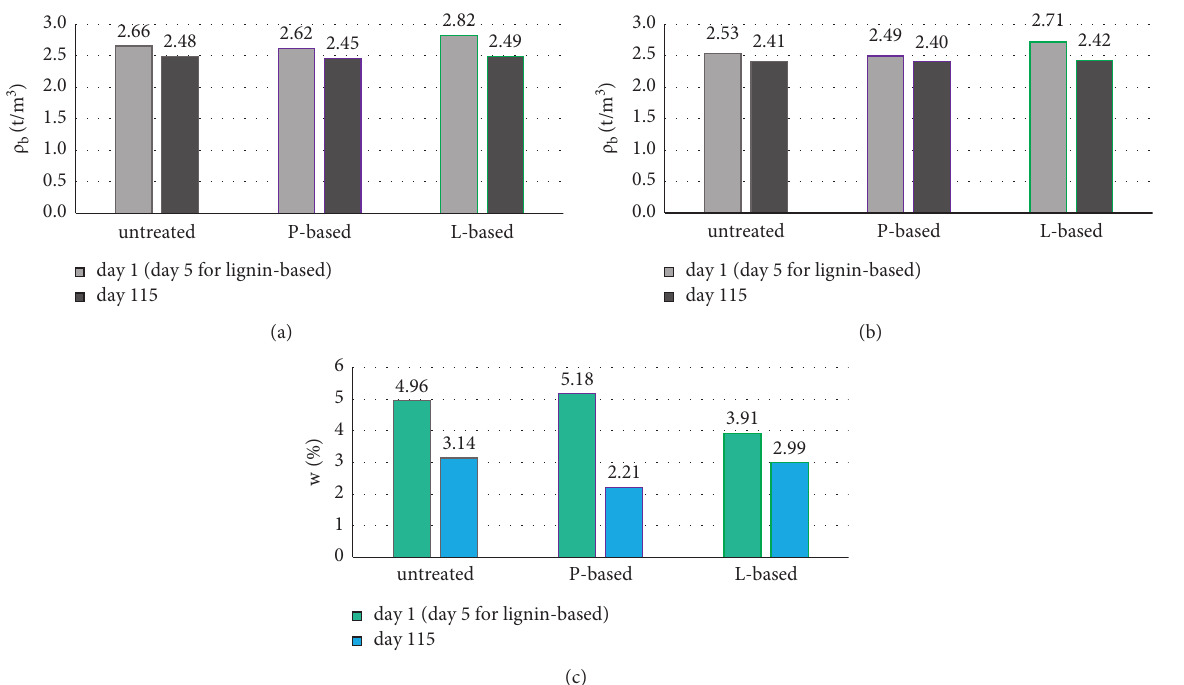
Figure 8: Bulk density (a), dry density (b), and water content (c). of the three test locations after construction and after 115 days [24].